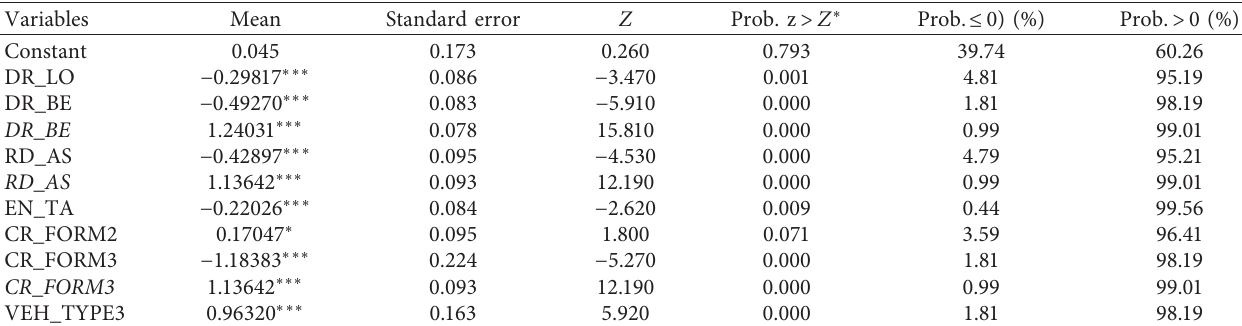
Table 6: Estimation results for the random-parameter ordered probit model.